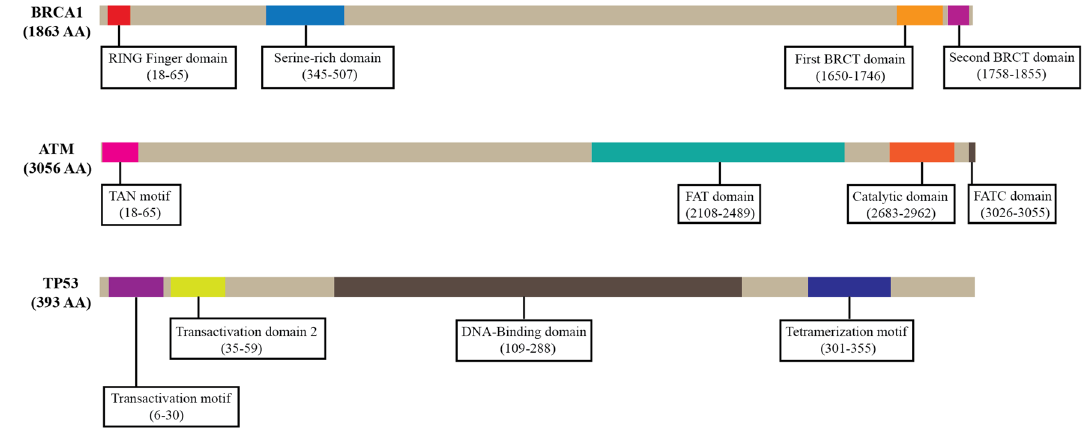
Figure 3. Domains and sequence intervals of BRCA1, ATM and TP53